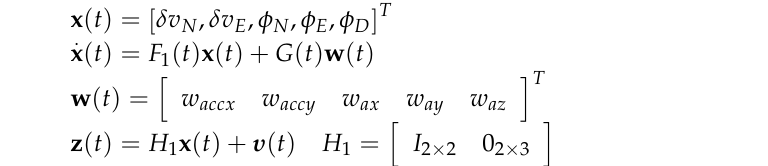
Figure 5. The experimental platform.